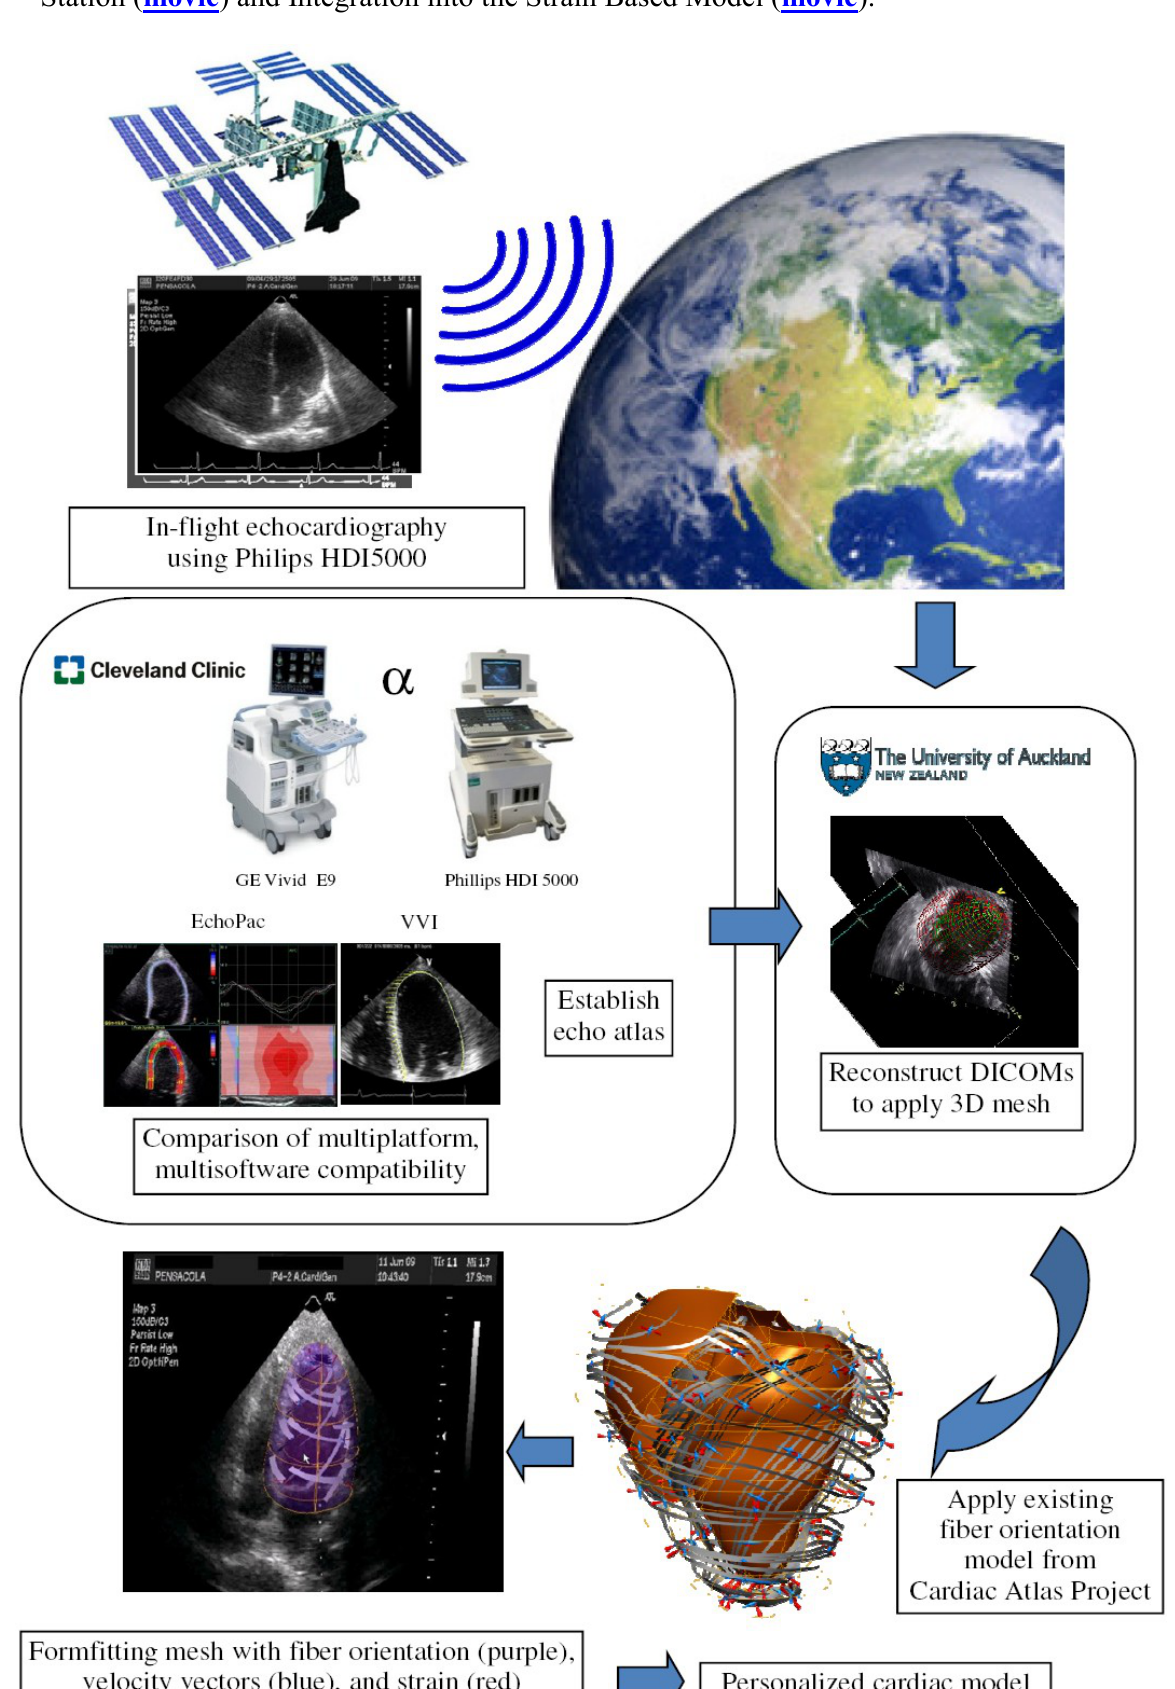
Figure 3. Workflow for Gathering Echocardiography Data from the International Space Station ( movie ) and Integration into the Strain Based Model ( movie